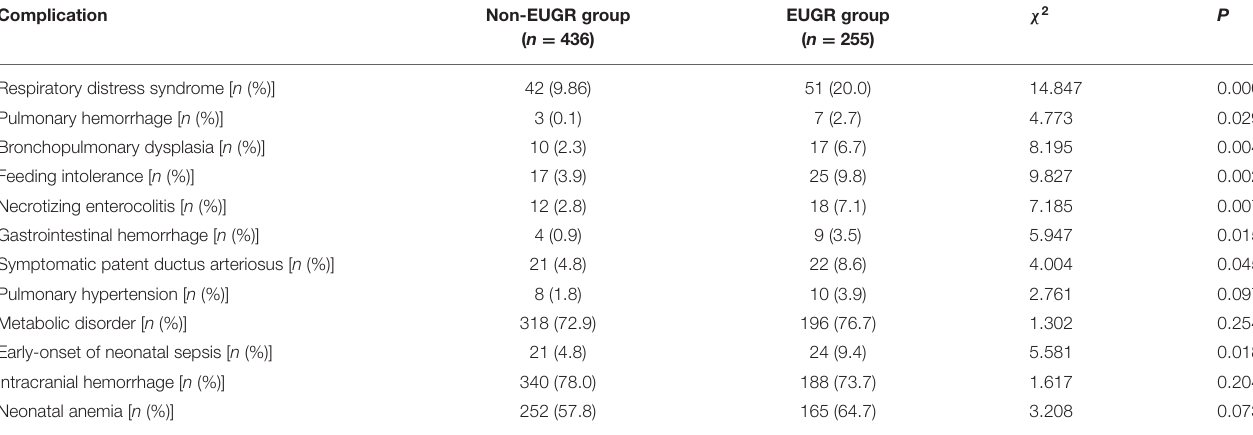
TABLE 5 | Comparison of the complications in preterm infants with a gestational age < 34 weeks between the non-EUGR group and EUGR Group. Complication